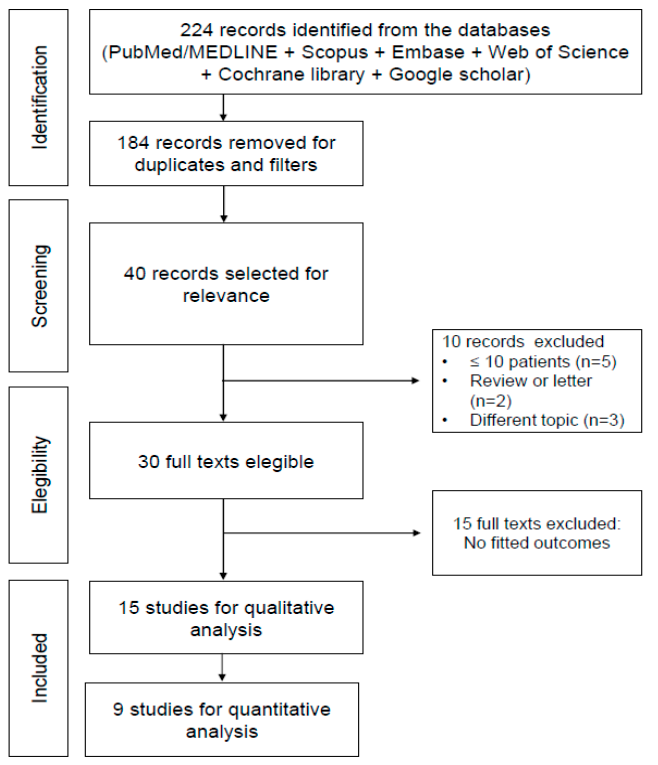
Figure 1. PRISMA flow-chart.